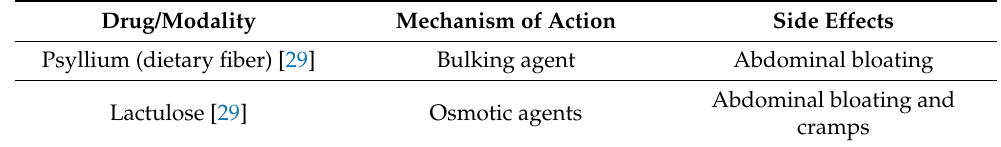
Table 2. Modalities used for management of bowel dysfunction